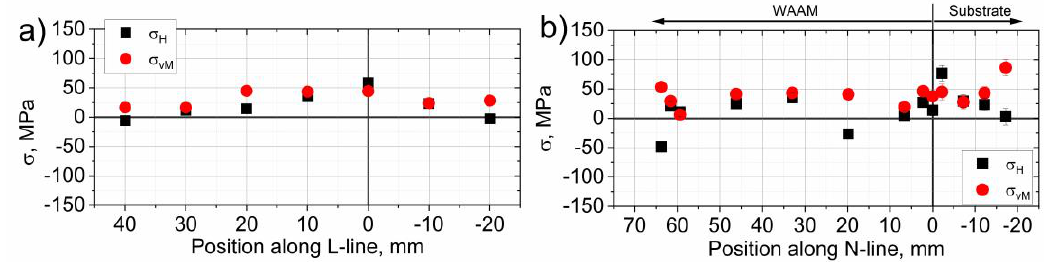
Figure 11. Hydrostatic and von Mises stress along ( a ) L-line, ( b ) N-line. Error bars are contained in the markers.